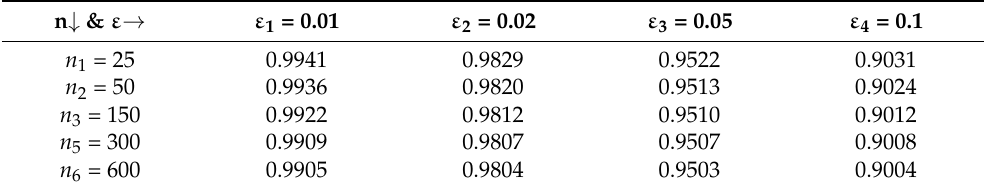
Table 12. Empirical levels and corresponding theoretical levels ( ε = 0.01, 0.02, 0.05, 0.1) and N =